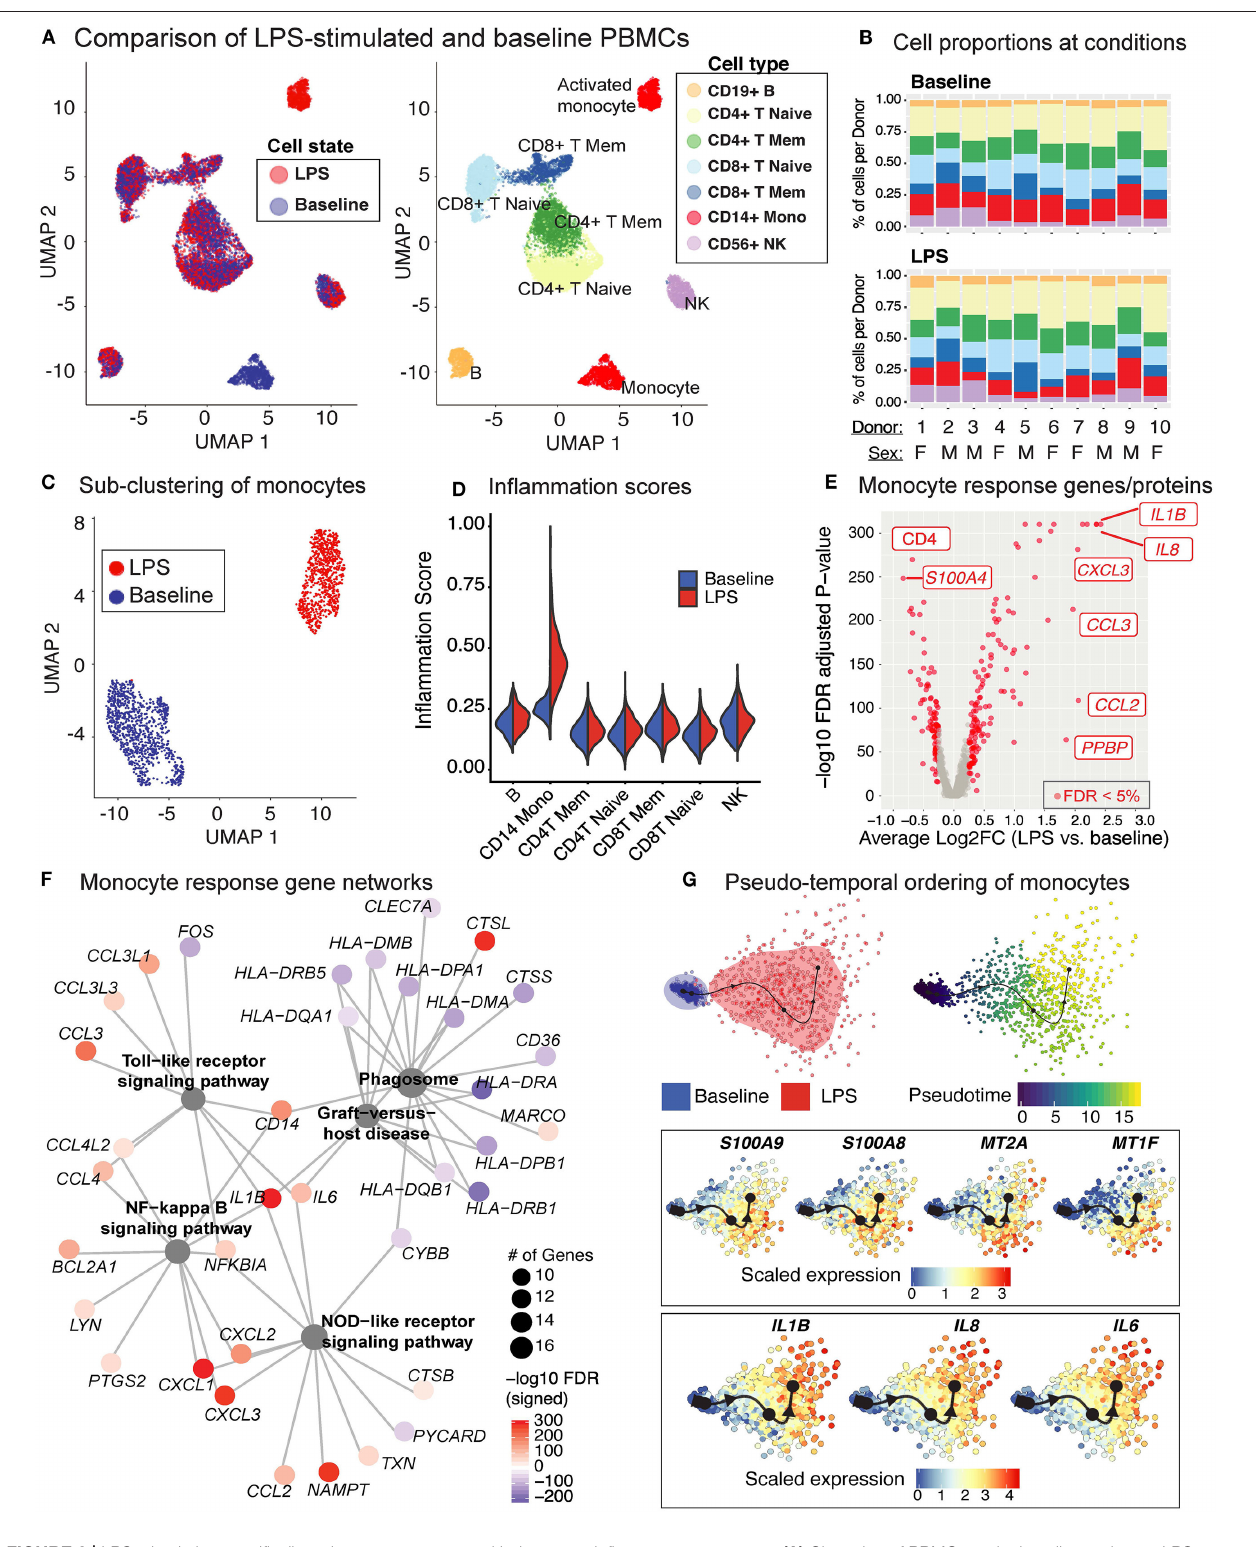
FIGURE 6 | LPS stimulation specifically activates monocytes and induces pro-inflammatory responses. (A) Clustering of PBMCs under baseline and upon LPS stimulation (left). Cell types were annotated using the expression of cell surface proteins (right). (B) Cell type compositions at baseline (top) and LPS condition